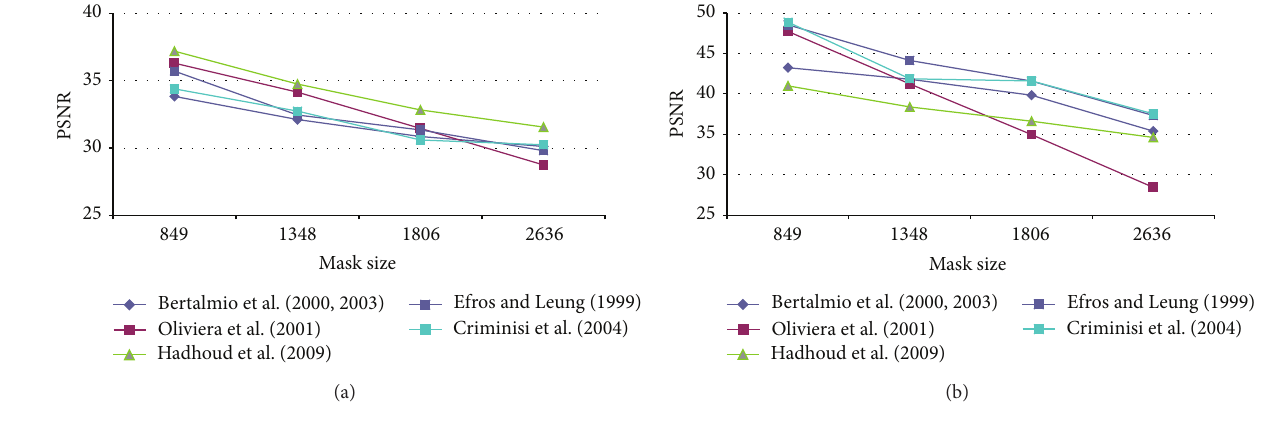
Figure 7: PSNR results for (a) cat fur and (b) fly test image.